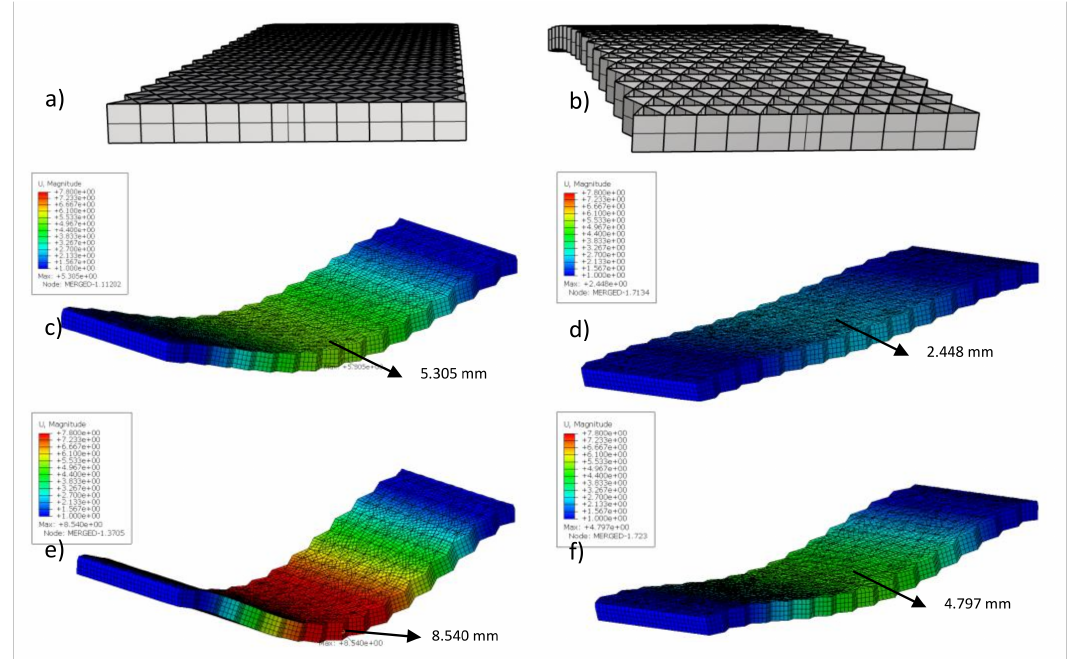
Figure 9. Geometry of sandwich panel with: ( a ) triangular cell configuration and ( b ) triangular cell configuration in an arch. Deformation for sandwich panel with: ( c ) triangular cell configuration (laminate); ( d ) triangular cell configuration (laminate) in an arch; ( e ) triangular cell configuration (quasi-isotropic); ( f ) triangular cell configuration (quasi-isotropic) in an arch.